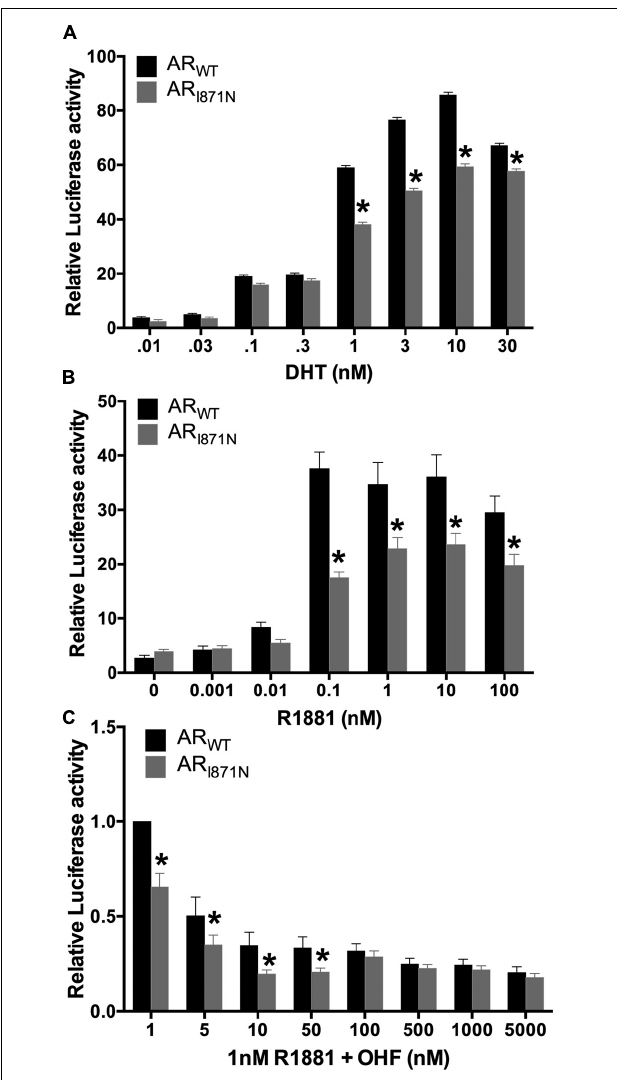
FIGURE 3 | Decreased transactivation activity of AR I871N mutation in reporter gene assay. CHO cells transfected with either AR WT or AR I871N , were exposed to DHT (A) or R1881 (B) at the different concentrations. In a competitive binding assay, where R1181 competed with the anti-androgen OHF for AR binding sites, the AR I871N mutation showed slightly weaker binding than the wild type (C) . Lower activity of AR I871N was observed when it was compared to the wild-type receptor. The experiments were conducted in triplicate. * P < 0.05 compared with wild type.